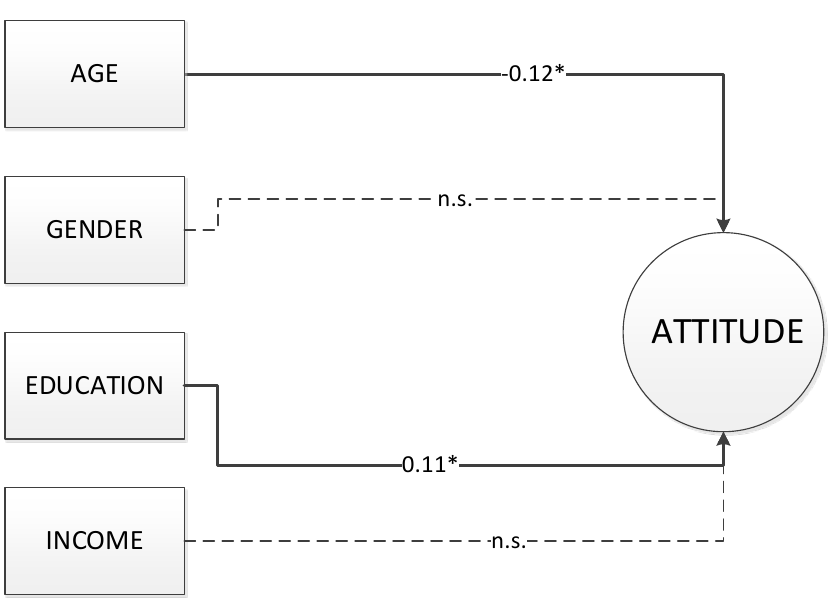
Figure 2. Estimated parameters along with corresponding statistical significance (Model A). * parameter is significant at the 10% significance level. n.s.: non-significant.